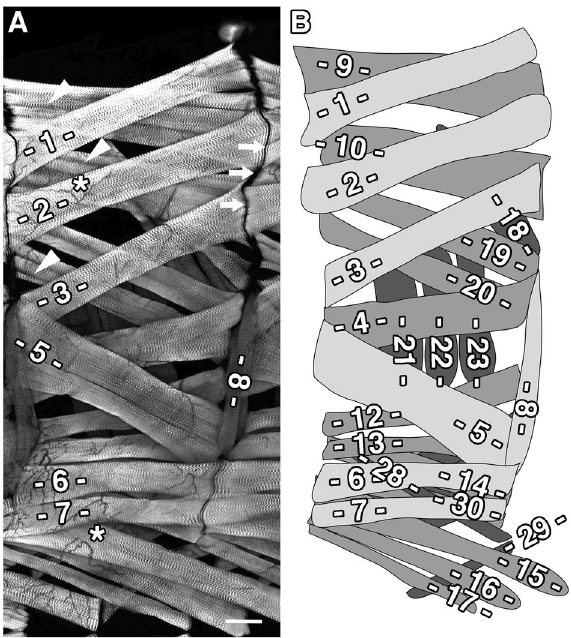
Figure 5. Internal muscles in abdominal segment A3 of a C. capitata larva. ( A ) Confocal image (projection) of abdominal segment A3 in a dissected third instar larva prior to the jumping phase and stained with phalloidin to label actin filaments in sarcomeres. Internal muscles M1–M8 are indicated. M5 is particularly massive and clearly conceals M4, which has thus been assigned to the medium layer. Arrows highlight posterior muscle attachment sites, arrowheads show "splitting" of muscle fibres, asterisks indicate areas with tracheal branches. ( B ) Corresponding scheme of the musculature. Internal muscles (light grey), medial muscles (dark grey) and external muscles (black). Muscle fibres are numbered based on their position and orientation. Not all muscle fibres labelled here are visible in the image shown in ( A ). Dorsal is up and anterior left. Scale bar 100